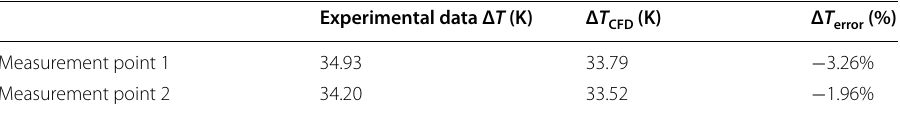
Table 4 Comparison of temperature rise between CFD results and experimental